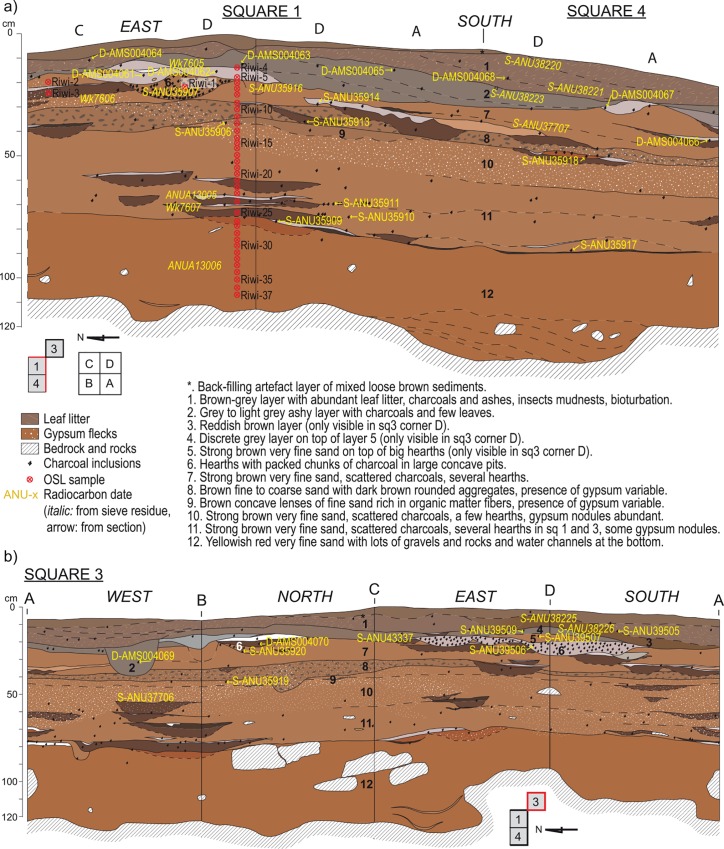
Stratigraphic profile and description of (A) squares 1 and 4, and (B) square 3. The location of OSL samples is marked in red, and the location of radiocarbon charcoal samples in yellow. Charcoal samples recovered from the sieve are given in italics, and charcoal samples taken from the section are marked with an arrow. CAD by Dorcas Vannieuwenhuyse.